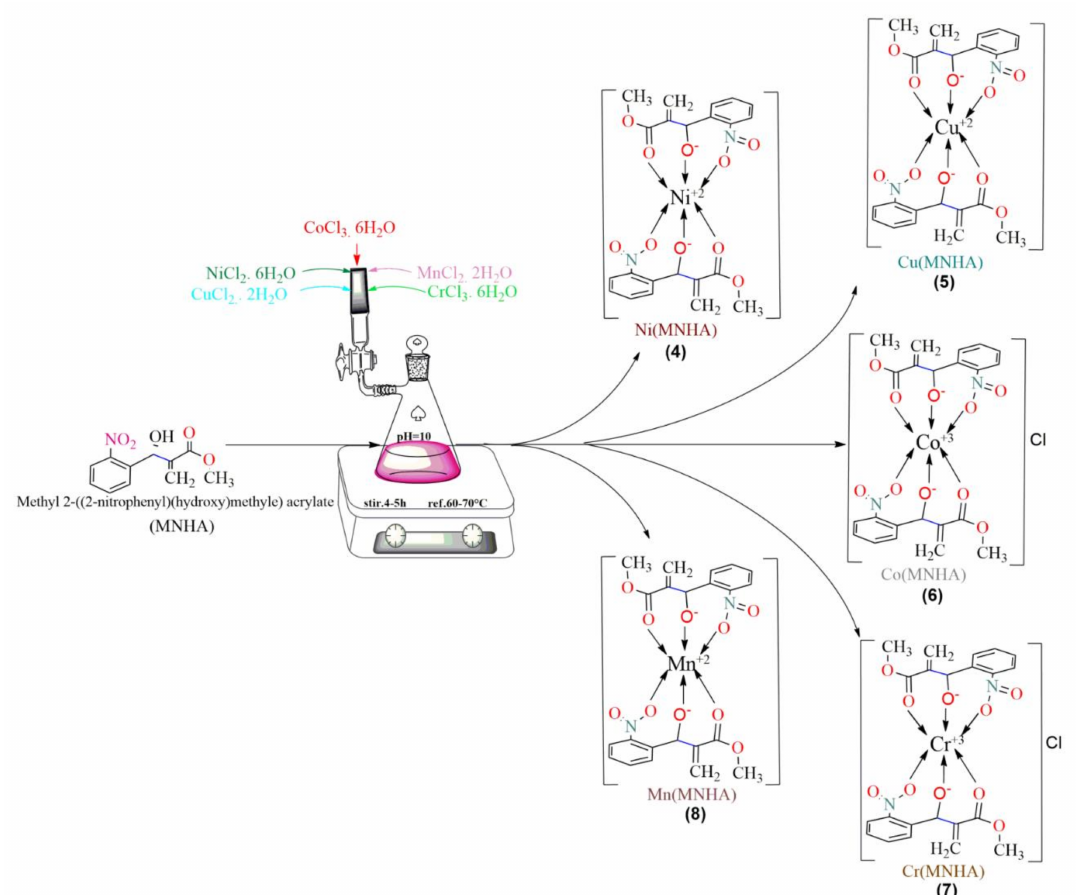
Scheme 2. Methodology adapted for syntheses of compounds 4 – 8